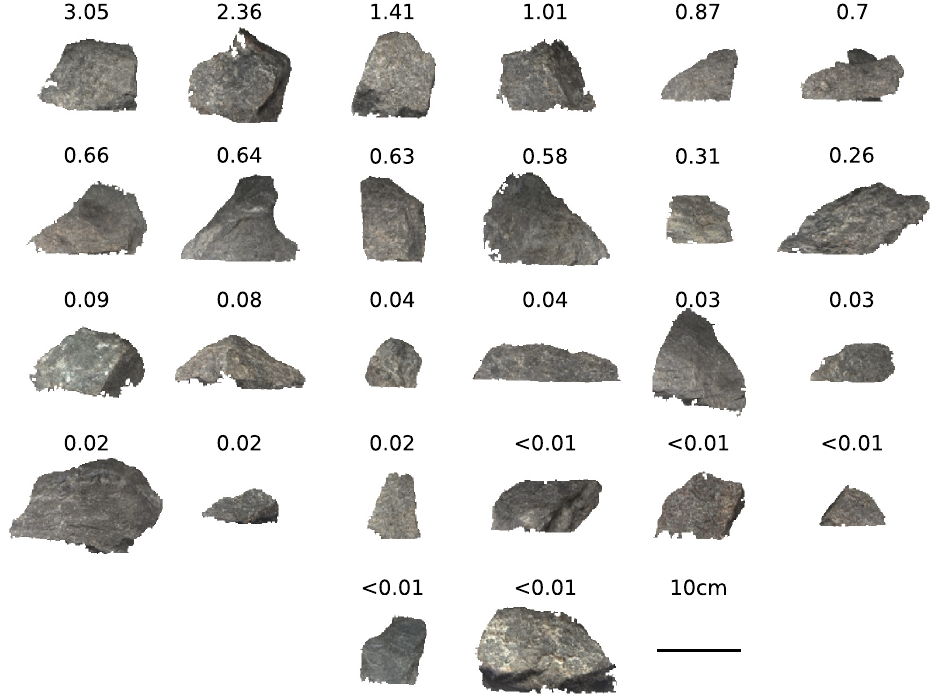
Figure 2. Approximate true colour image of gold ore samples scanned in the laboratory, labelled by assayed gold concentration (ppm). Red, green, and blue channels are the 643nm, 550nm, and 464nm bands from the visible-near-infrared (VNIR) camera. 0.16